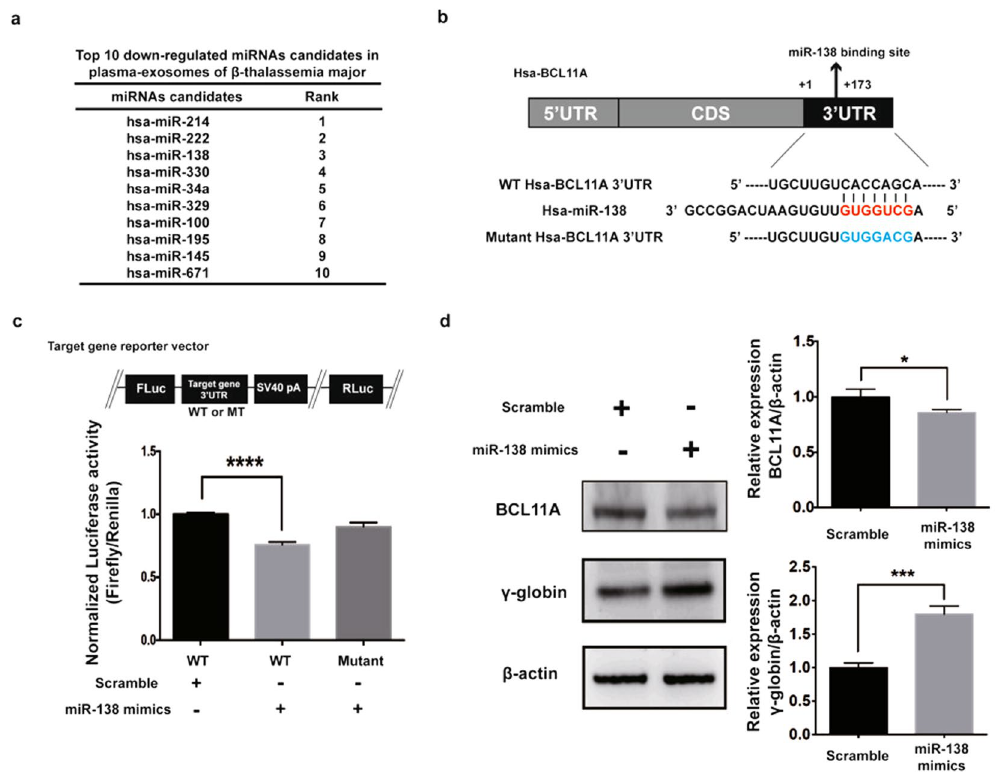
Figure 4. miR-138-5p targets BCL11A and regulates γ -globin expression. ( a ) Top10 down-regulated miRNA candidates in the plasma exosomes of β -TM as determined by NGS analysis. ( b ) Predicted miR-138-5p binding site in the 3 ′ UTR of BCL11A with sequence complementarity. ( c ) Schema of reporter vector (pmirGLO) carrying either WT or mutant 3 ′ UTR of BCL11A. Luciferase assays using a reporter vector (pmirGLO) carrying either WT or mutant 3 ′ UTR of BCL11A in K562 cells transfected with scramble control microRNA mimics (controls, 100 nM), miR-138-5p mimics (100 nM) for 24 hrs. Experiments were performed in triplicates. The values represented are mean ± SD, one-way ANOVA, **** P < 0.0001, Prism6 (GraphPad Software Inc.). ( d ) Western blot of BCL11A and γ -globin expression in the presence of miR-138-5p mimics in K562 cells. Experiments were performed in triplicates. Values represented are mean ± SD, t-test analysis, * P < 0.05, Prism6 (GraphPad Software